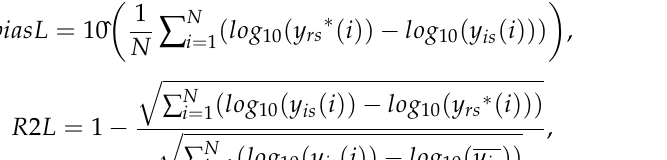
Figure 4. Quality analysis of the atmosphere correction of satellite data. Examples of the comparison of ship and satellite estimations of R OC 2 . Left column shows MODIS/Terra measurements ( a , c ), right column shows MODIS/Aqua measurements ( b , d ). To focus only on the development of bio-optical algorithms, shipborne surface R OCx data were used for further analysis.